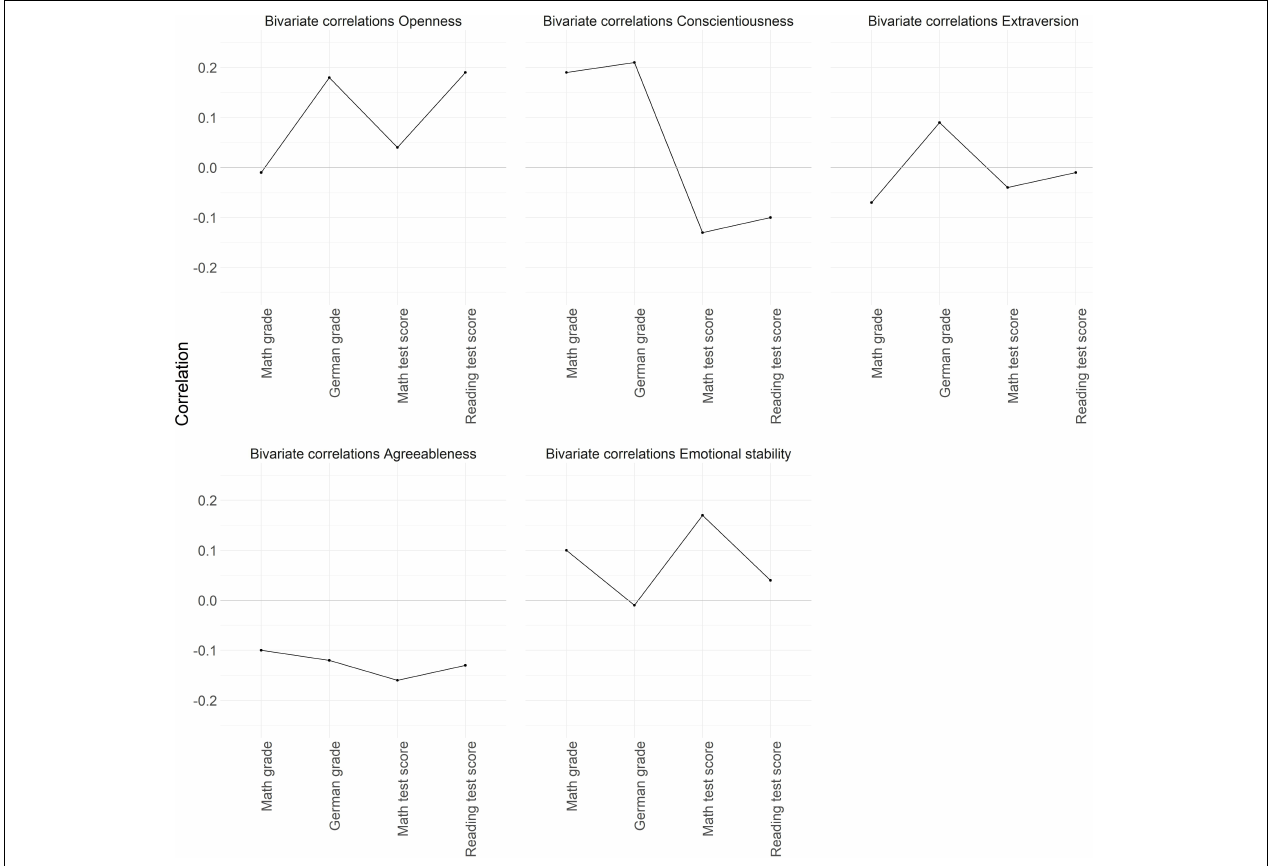
FIGURE 1 | Bivariate correlations of the Big Five personality traits with teacher-assigned grades and standardized test scores (in mathematics and